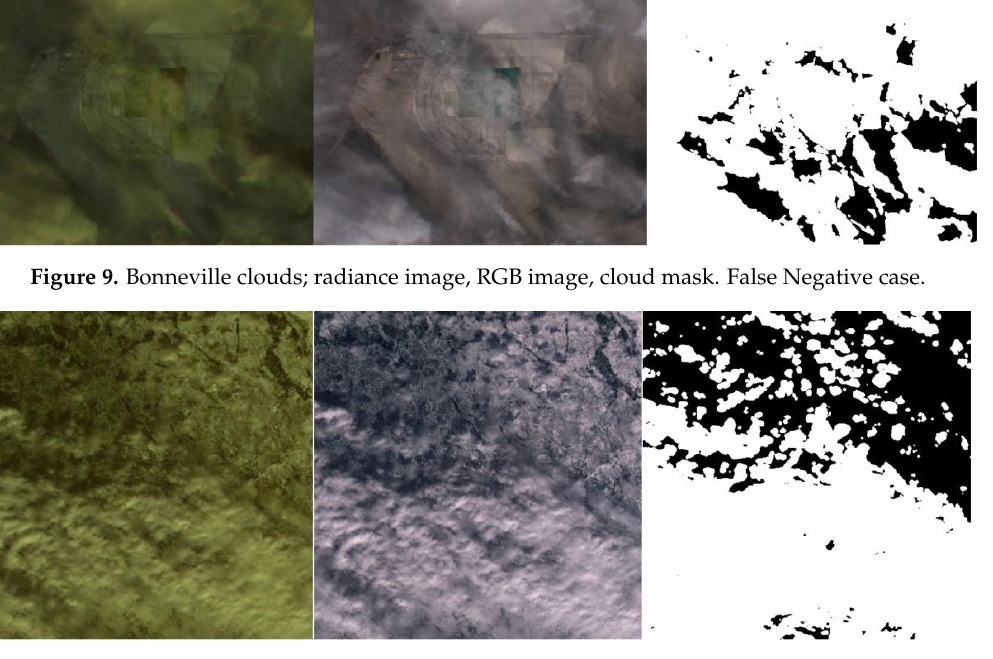
Figure 10. Erie ice and clouds; radiance image, RGB image, cloud mask. False Positive case.